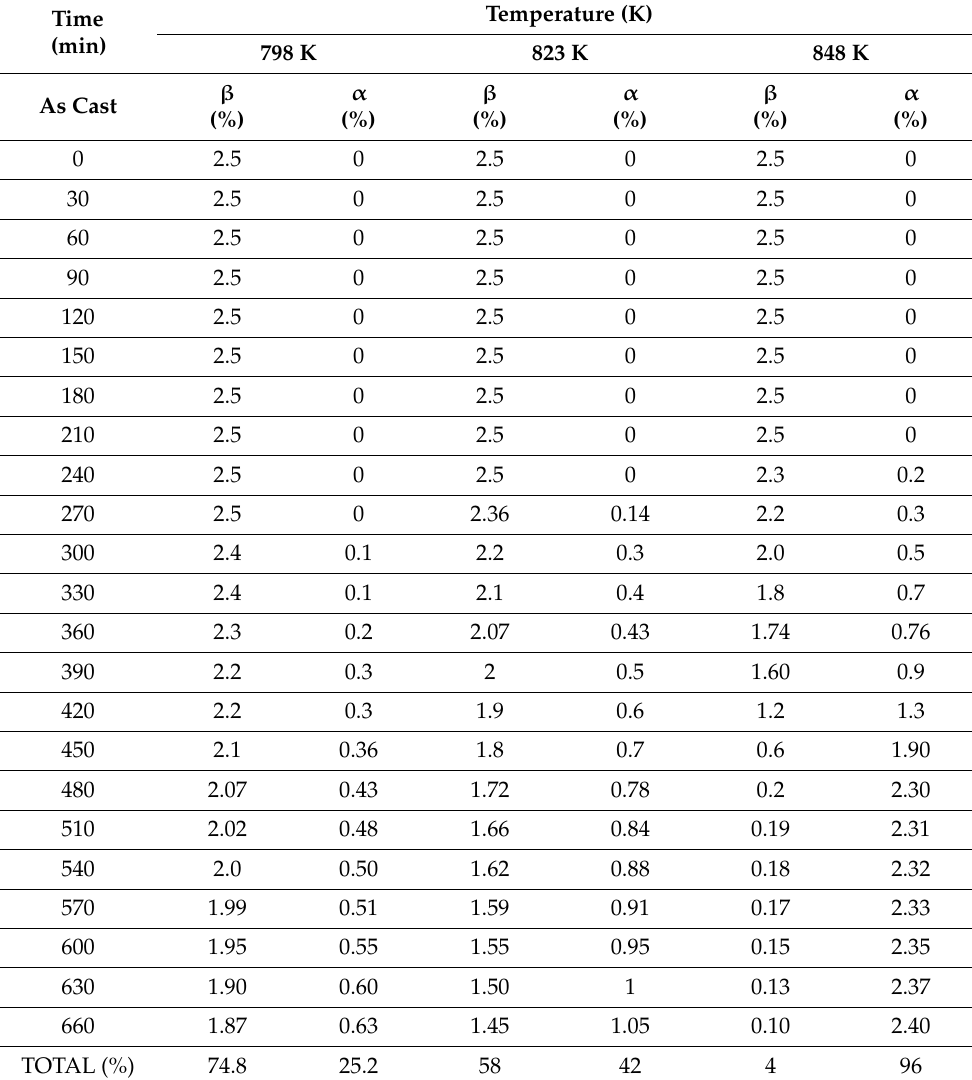
Table 2. Results obtained for the percentages of phases β and α , determined by the Image-Pro Plus software at different temperatures of homogenization